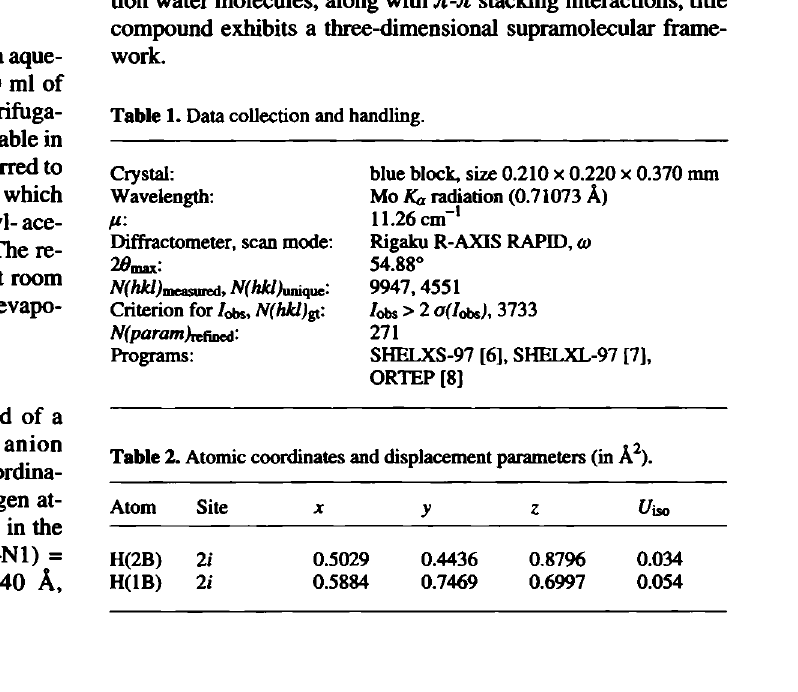
Table 1. Data collection and handling.